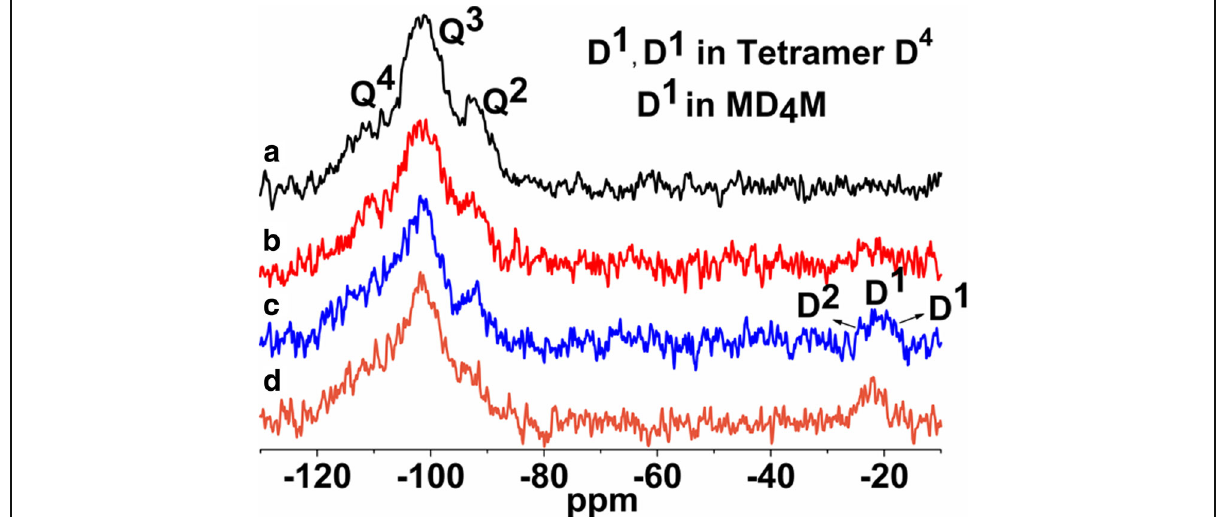
Fig. 11 29 Si CP/MAS NMR spectra of ( a ) neat fumed silica, ( b ) modified fumed silica with CPDMS, modified with ( c ) mixtures of CPDMS